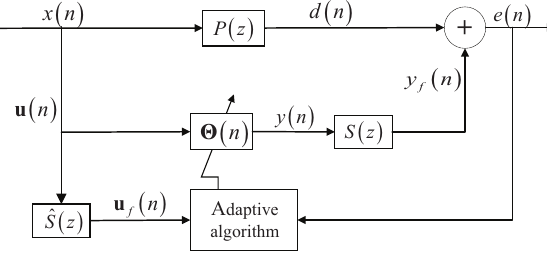
Figure 1. Block diagram of the feed-forward ANC systems in a